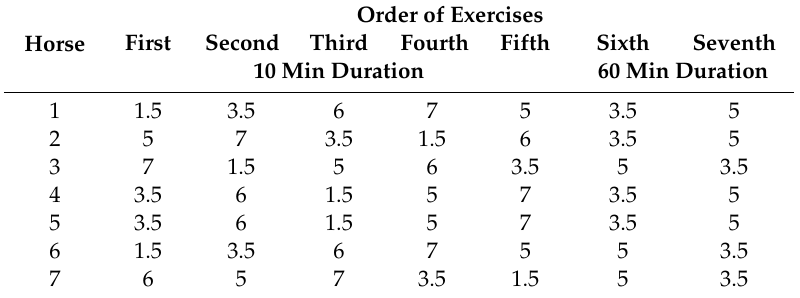
Table 1. Order of exercises for each horse at the di ff erent speeds (m / s) for 10 and 60 min duration.